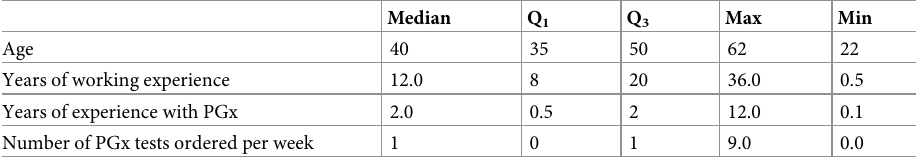
Table 2. Demographics of the survey participants.